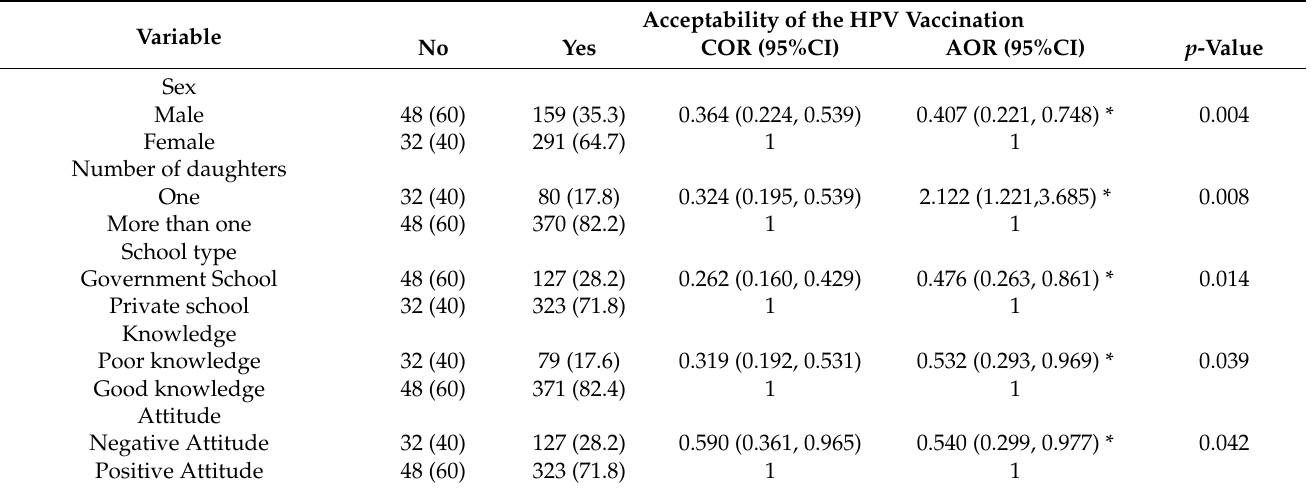
Table 5. Multivariable and bivariate analyses of factors associated with the acceptance of human